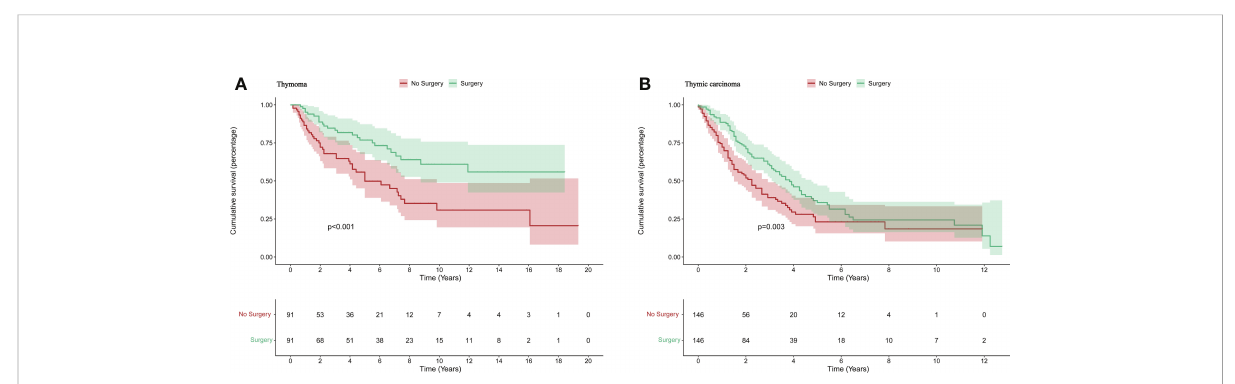
FIGURE 2 Propensity score matching(PSM): The disease-speci fi c survival for advanced thymoma (A) and advanced thymic carcinoma (B) after PSM.